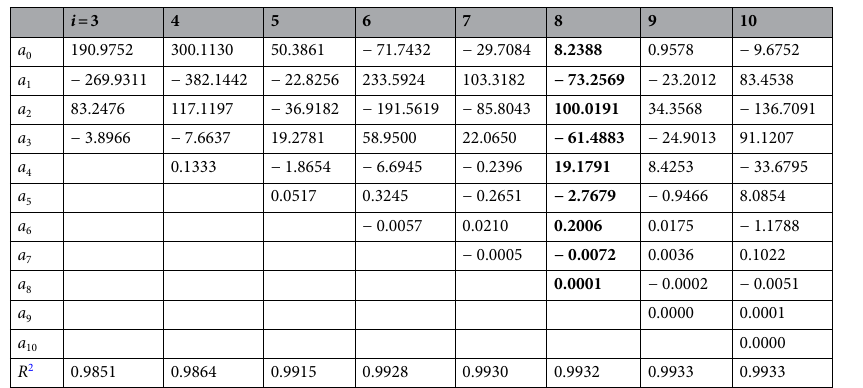
Table 8. The fitting results for wind power output with different degree i . The eight-degree polynomial with the highest correlation coefficient R 2 = 0.9932 is selected as the best model for wind power output. For nine- degree polynomial, its correlation coefficient higher slightly than that of eight-degree polynomial, but the coefficient